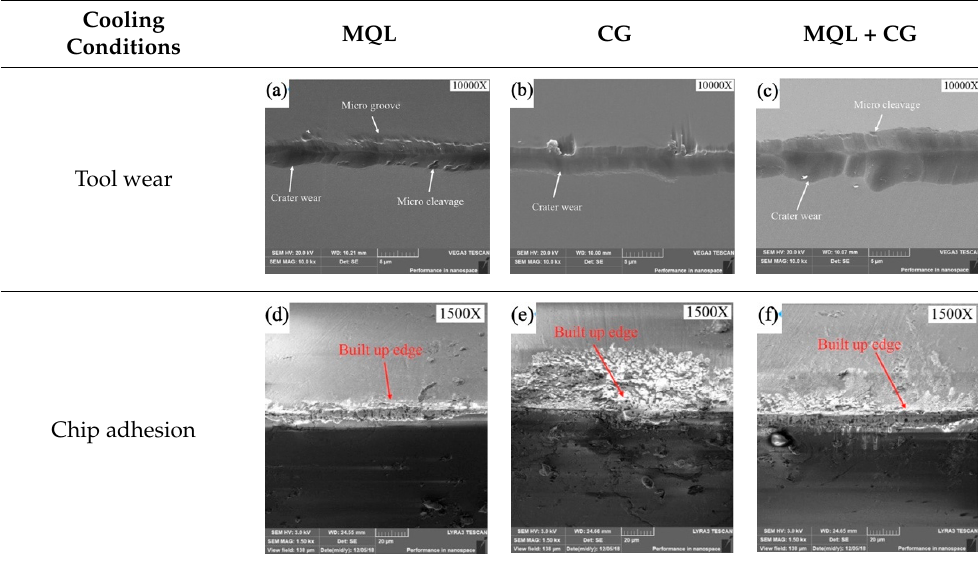
Table 4. Tool wear and chip adhesion to the cutting tools under the various cooling condition: MQL; CG; and MQL + CG, adapted with permission from Ref. [163]. 2017, Elsevier.